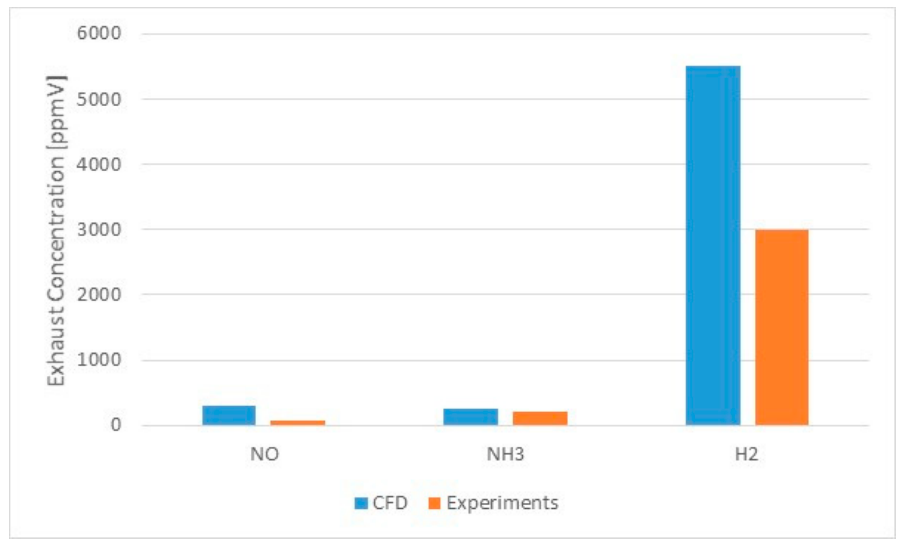
Figure 3. Validation using exhaust emissions profiles. Experiments as in [34,39].